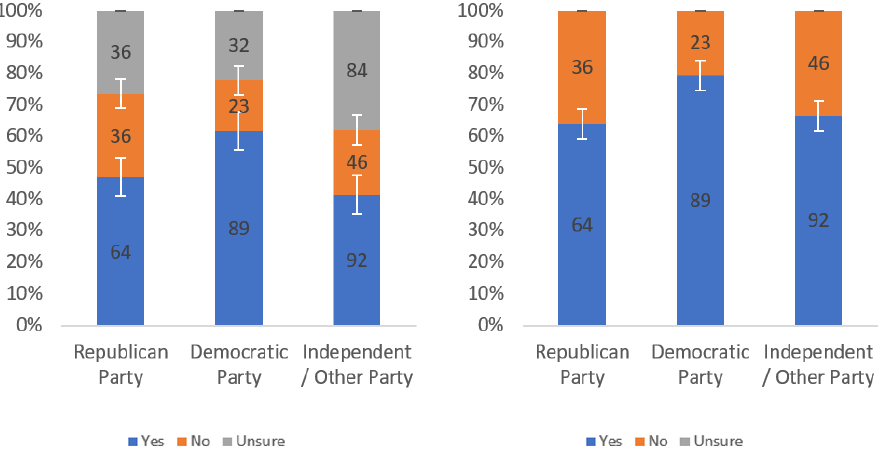
Figure A26. Responses regarding others’ willingness to review by party affiliation including ( left ) and excluding ( right ) unsure responses.